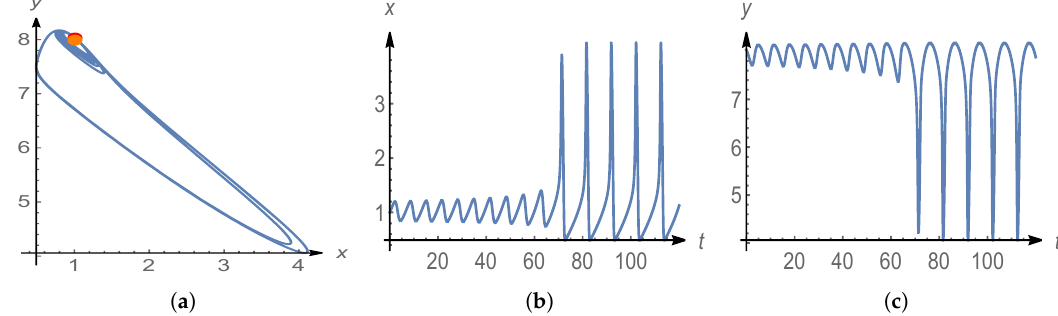
Figure 5. Model 1 with a stable outer and an unstable inner limit cycle. The trajectory is going outward, approaching the large limit cycle as t tends to + ∞ and the small limit cycle as t tends to − ∞ . The distance of the initial point from the singular point is d =